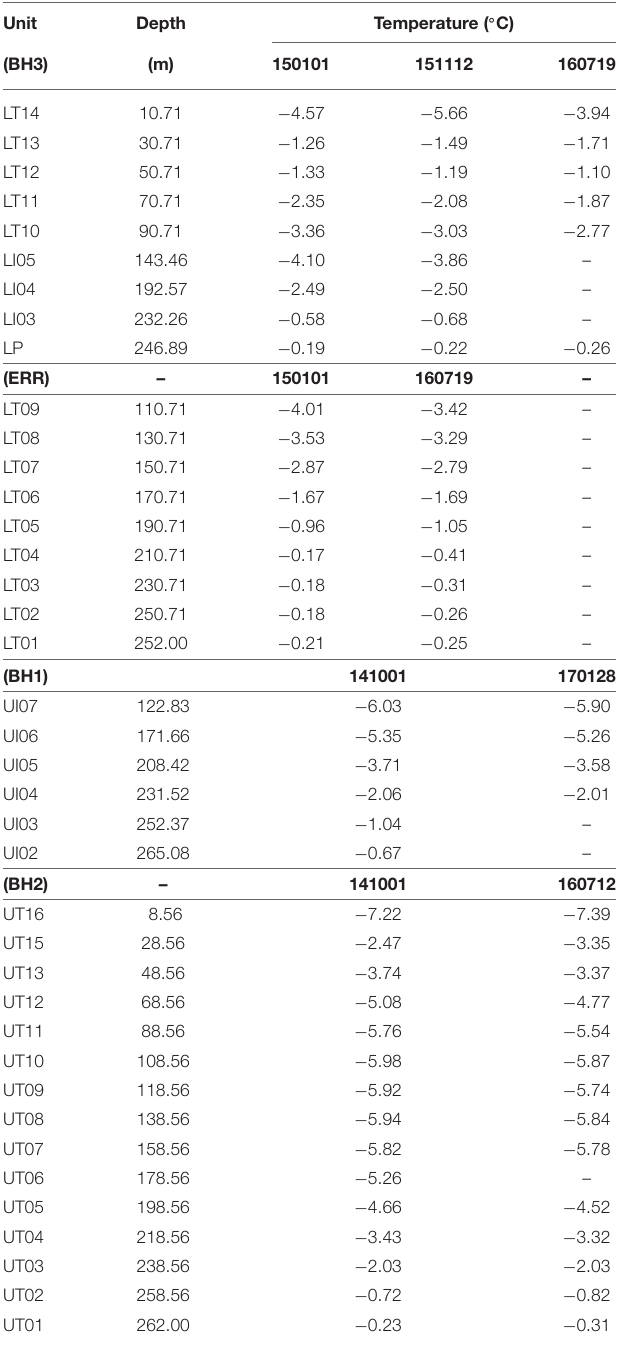
TABLE 4 | Selected daily mean temperature values corresponding to profiles shown on Figure 4a (dates as YYMMDD).